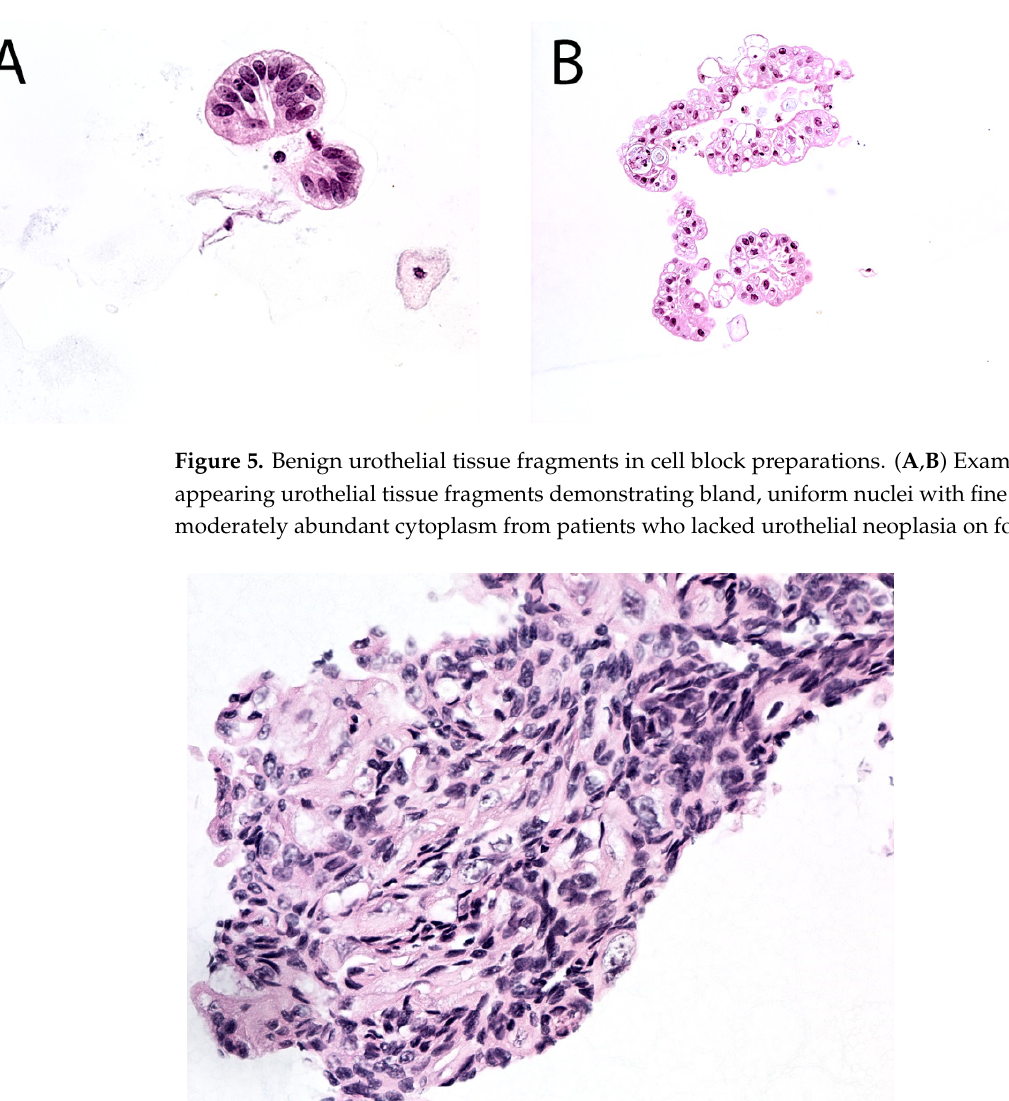
to providing material for IHC and to support a urothelial origin [61]. In some cases, CBs can highlight the papillary architecture of